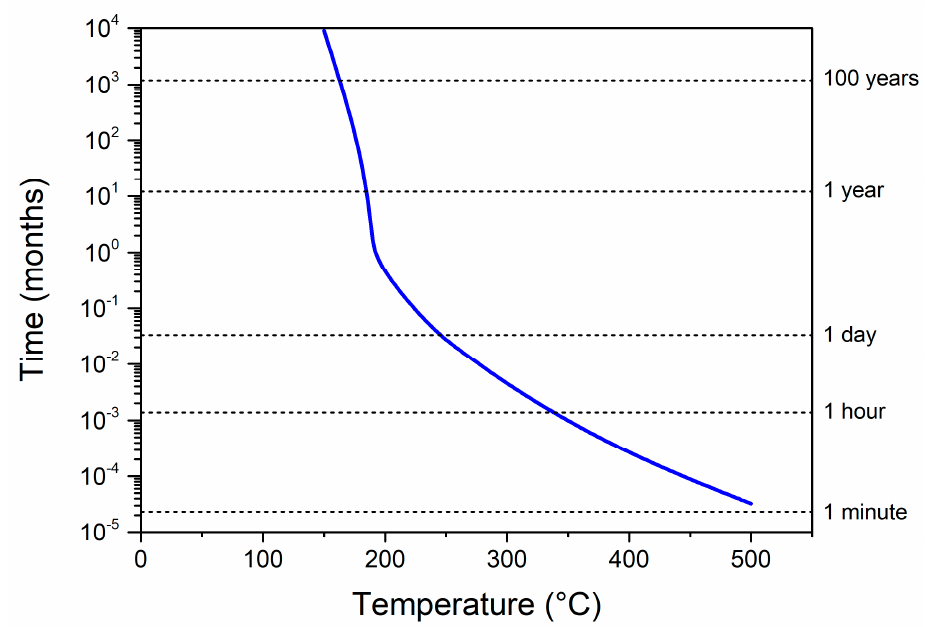
Figure 3. Simulated aging predictions of Al/CuO nanolaminates, depending on time and temperature, to reach an aging leading to the complete conversion of the natural Al x Cu y O z interface into a well-defined amorphous alumina layer.